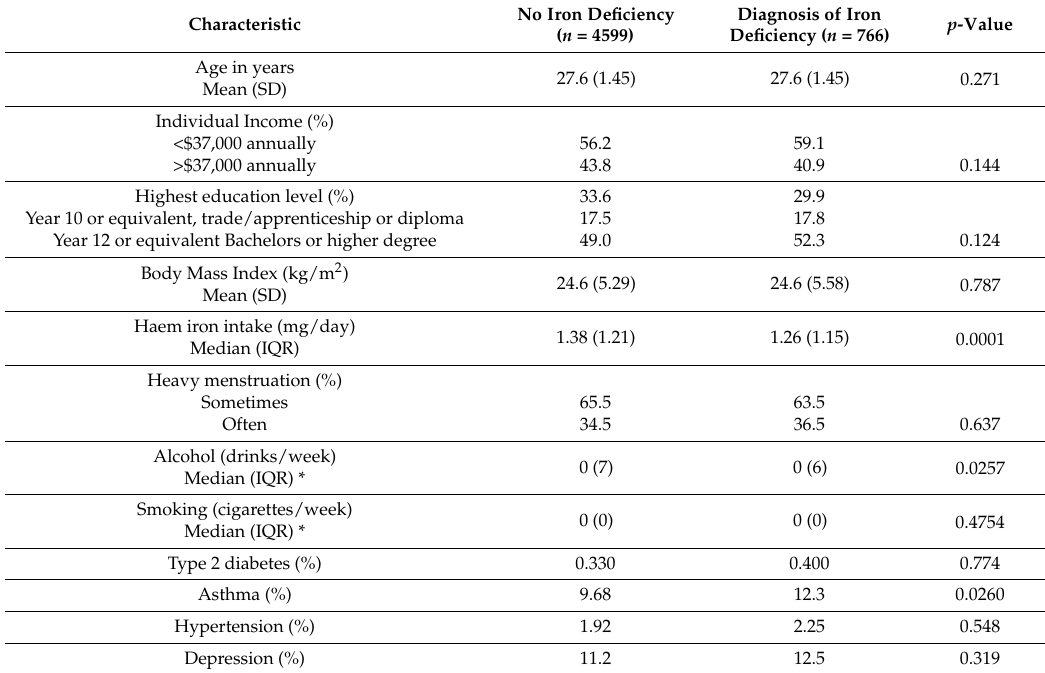
Table 2. Characteristics of young cohort ALSWH women in the study sample at survey three (baseline) and associations with self-reported diagnosed iron deficiency at survey